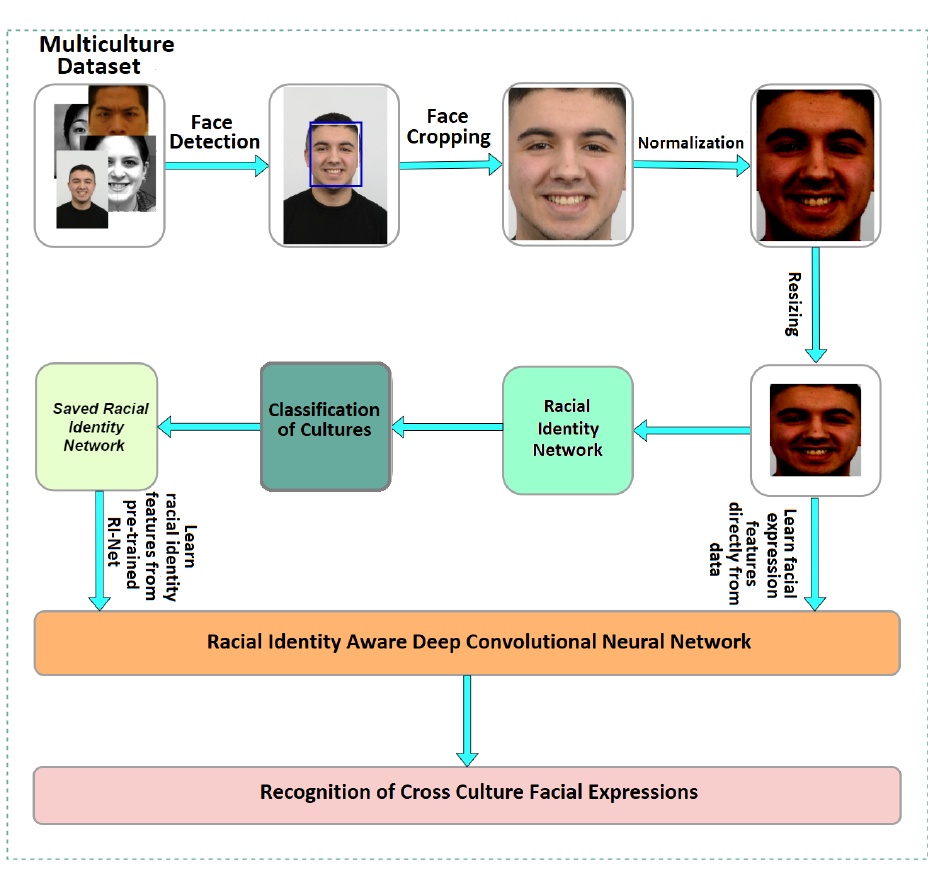
Figure 2. Racial identity awareness cross-culture facial expressions recognition